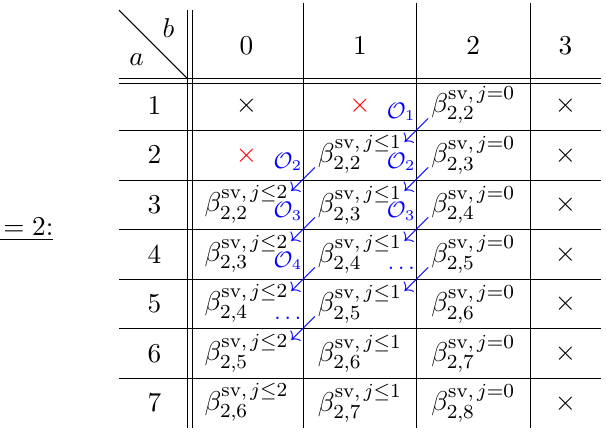
obtained from Poincaré sums over y a E 2 ,k defined in (3.63). ‘